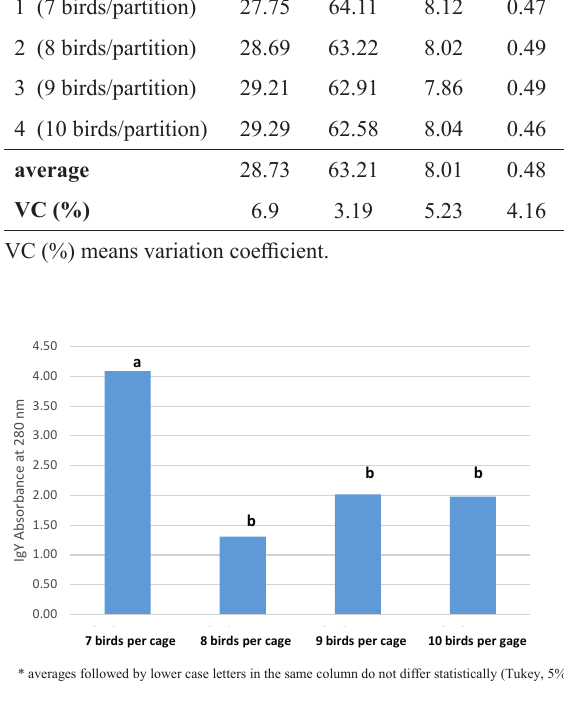
Figure 1 - IgY from Quails eggs at different densities of caging, from 7 birds per cage up to 10 birds per